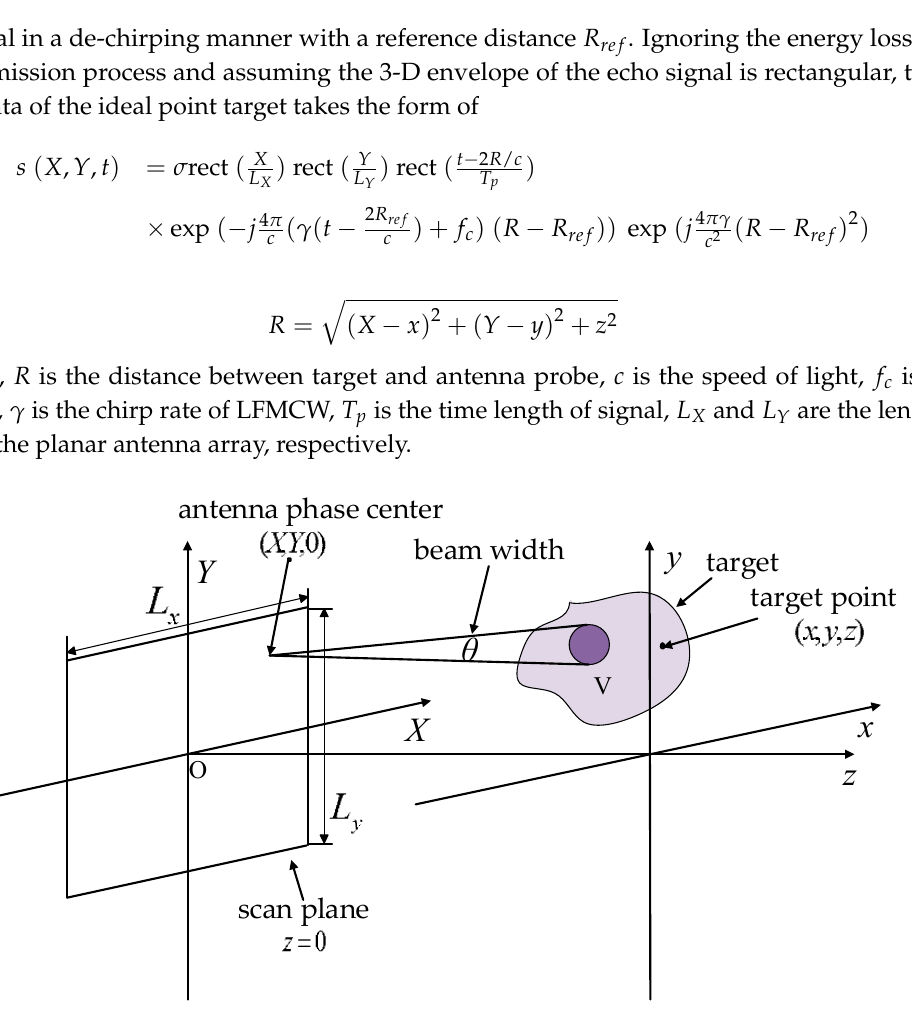
Figure 1. Geometry of near-field planar millimeter-wave holographic imaging.